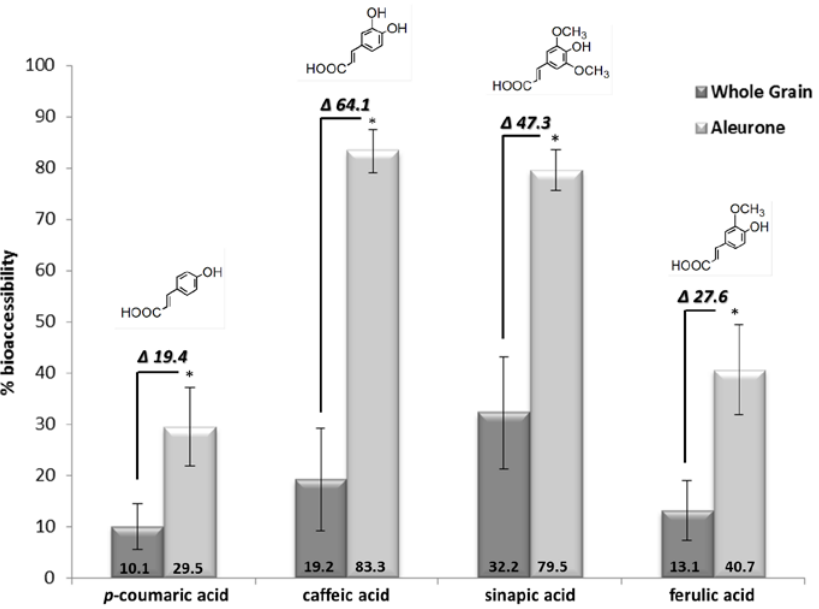
Figure 1. Bioaccessibility (%) of the detected phenolic acids in the two breads (mean ± SD, n = 12). * Significant differences between the two breads ( p < 0.05). Δ, difference of bioaccessibility between the two breads.